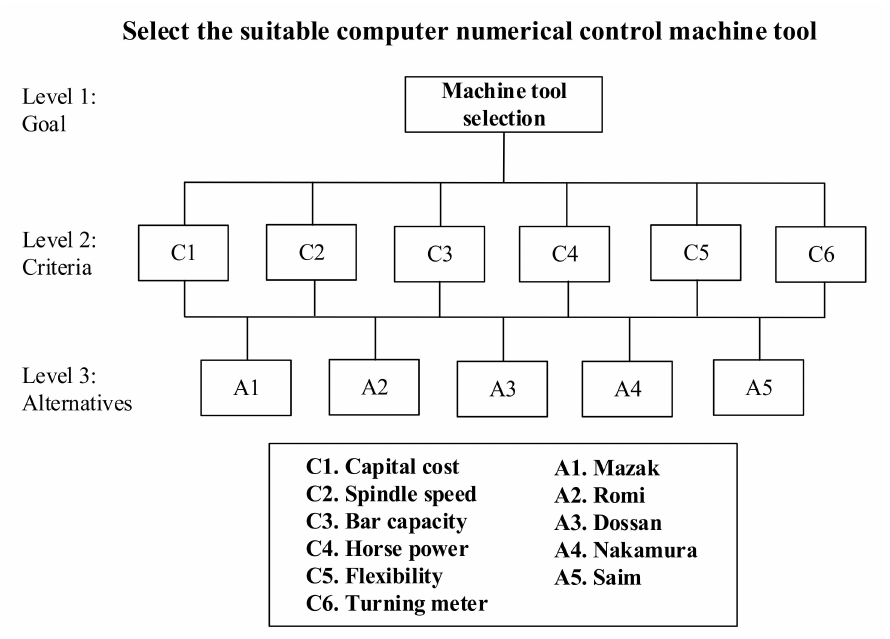
Figure 2. Hierarchical structure for selecting the optimal computer numerical control (CNC) machine tool.